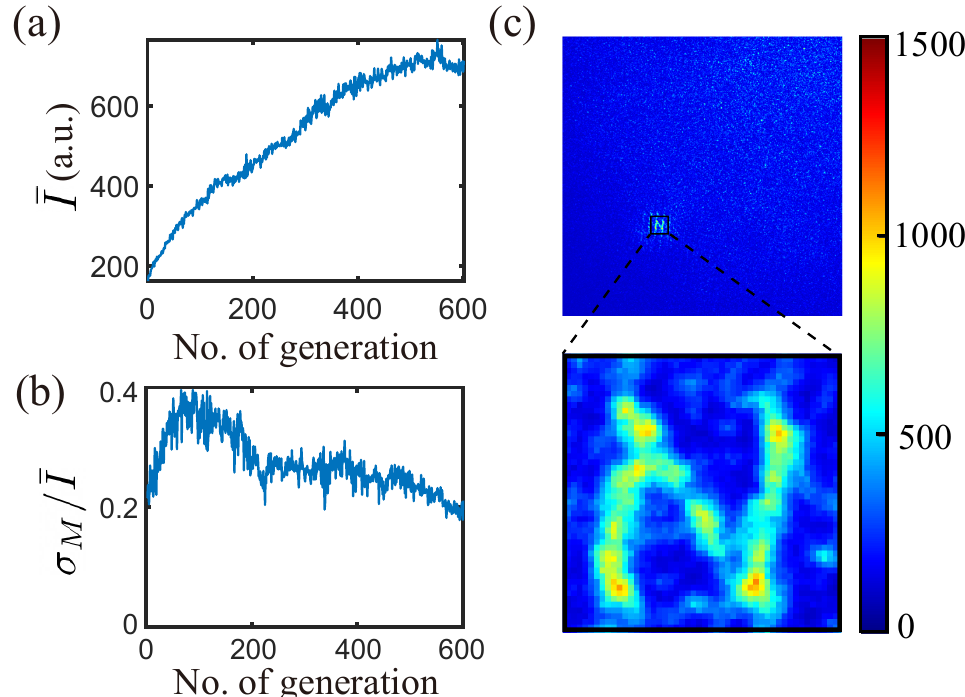
Figure 7. Multi-point focusing optimization using SBGA with two discriminants ( f 1 , f 2 ). ( a ) The average intensity of the predefined targets over generations. ( b ) The relative standard deviation of the intensity of all the targets. ( c ) Optimal speckle